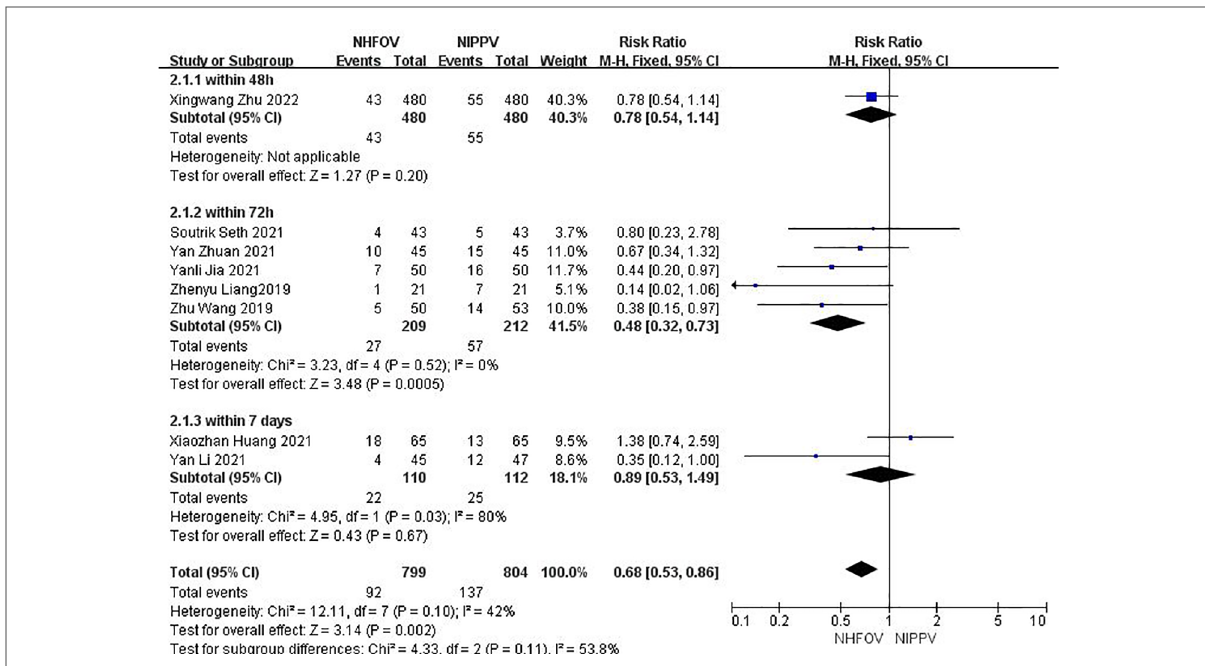
FIGURE 3 Results of the meta-analysis of reintubation rates; NHFOV, noninvasive high-frequency oscillatory ventilation; NIPPV, nasal intermittent positive- pressure ventilation.